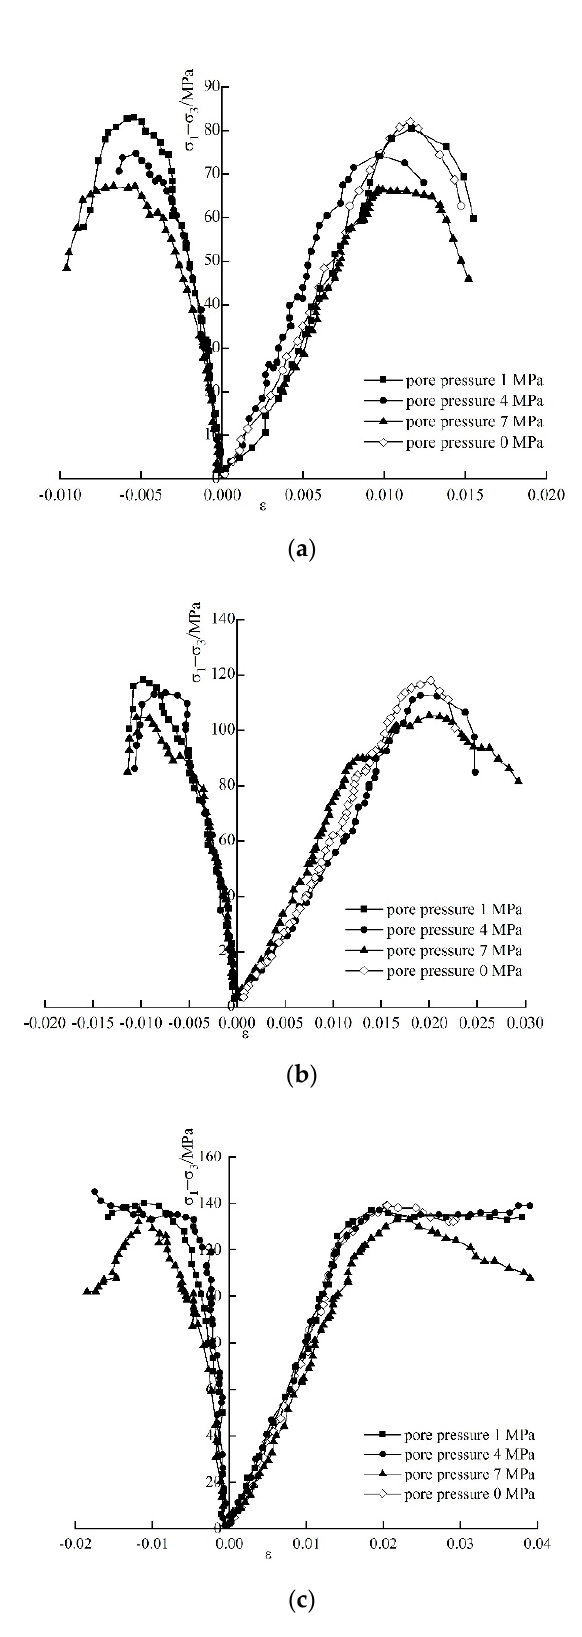
Figure 4. Stress–strain curves of sandstone during failure under hydro-mechanical coupling ( a ) Confining pressure 10 MPa, ( b ) Confining pressure 20 MPa, ( c ) Confining pressure 30 MPa.